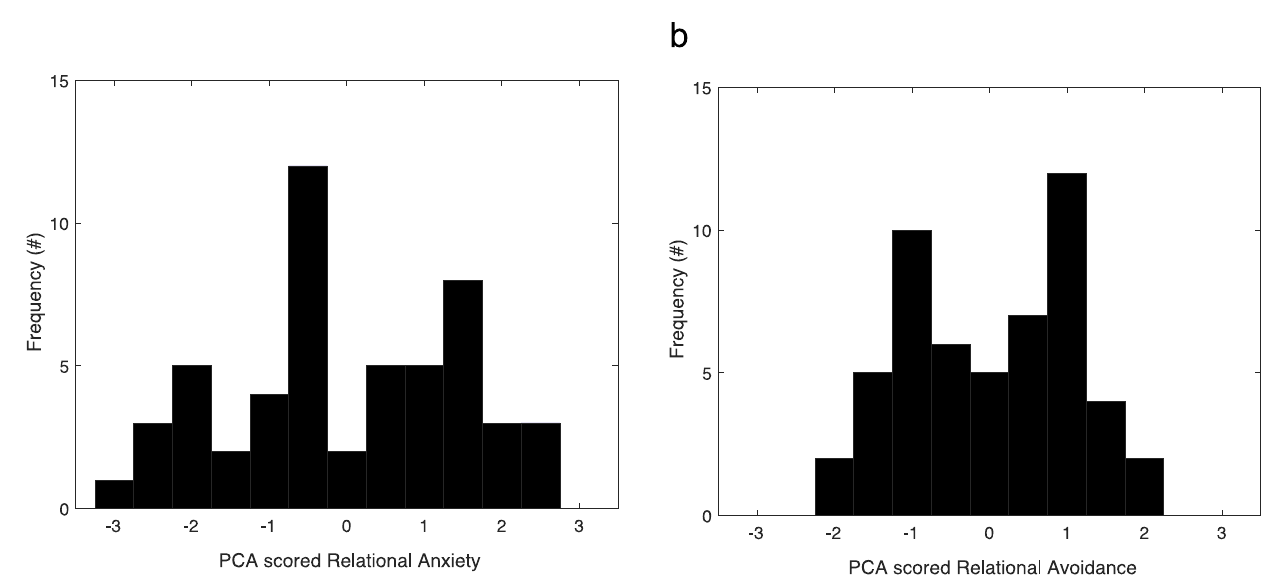
Fig 3. Relational attachment. Distribution of relational avoidance and anxious attachment styles in the shared PCA score. Low score means less secure attachment.